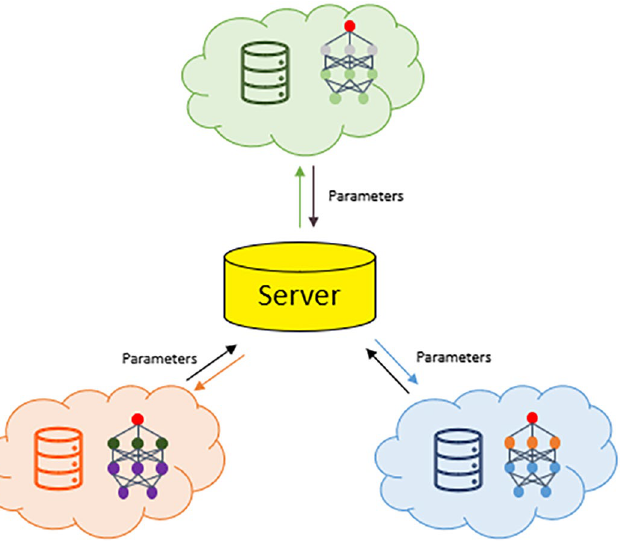
Figure 1. Schematic diagram of model training framework with multi-source databases. This framework contains three clients and one “Sever”. Each client has one local dataset in this illustration, and the “Server” is used to receive and send the model